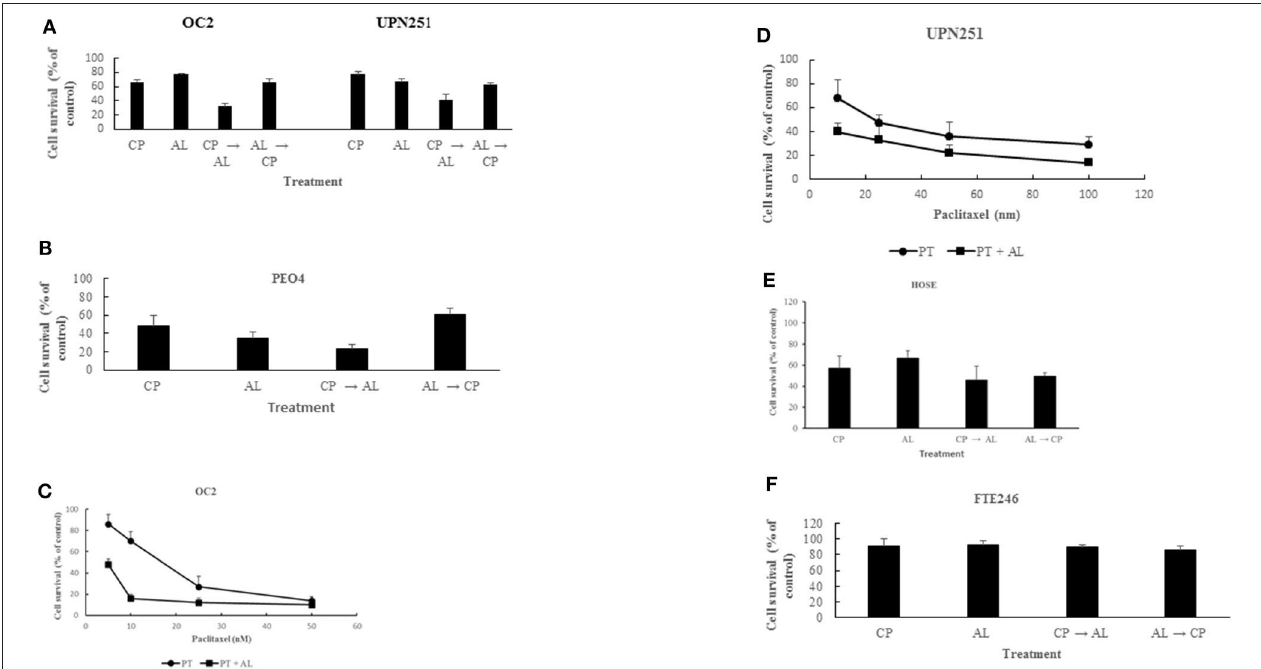
FIGURE 1 | Synergistic enhancement of cisplatin and paclitaxel cytotoxicity by alisertib. (A) OC2 and UPN251 cells were treated with 2.5 or 1 µ M cisplatin (CP), respectively, for 3h and 50nM alisertib for 48h either before or after treatment with CP. Following drug treatment cells were re-incubated in drug-free medium for 120h before determination of cell counts. CP → AL was significantly different from AL → CP, CP, or AL treatment ( p < 0.001). (B) PEO4 cells were treated with 2.5 µ M CP and 50nM AL. Treatment and evaluation parameters like (A). CP → AL was significantly different from AL → CP, CP, or AL treatment ( p < 0.002). (C,D) OC2 and UPN251 cells were treated with indicated concentrations of paclitaxel (PT) alone for 6h or PT for 6h followed by alisertib (AL) for 48h. Following drug treatment cells were re-incubated in drug-free medium for 120h before determination of cell counts. Data are mean ± standard deviation from at least triplicate experiments. Treatment with PT followed by AL significantly different from treatment with PT alone ( p < 0.001 at 5–25nM PT in OC2 and p < 0.05 at 10–100nM PT in UPN251). (E) HOSE and (F) FT246 cells were treated with 2.5 µ M (CP) for 3h and 50nM alisertib for 48h either before or after treatment with CP. Following drug treatment cells were re-incubated in drug-free medium for 120h before determination of cell counts. CP → AL, AL → CP, CP, or AL treatment were not significantly different ( p > 0.05). Data are mean ± standard deviation from at least triplicate